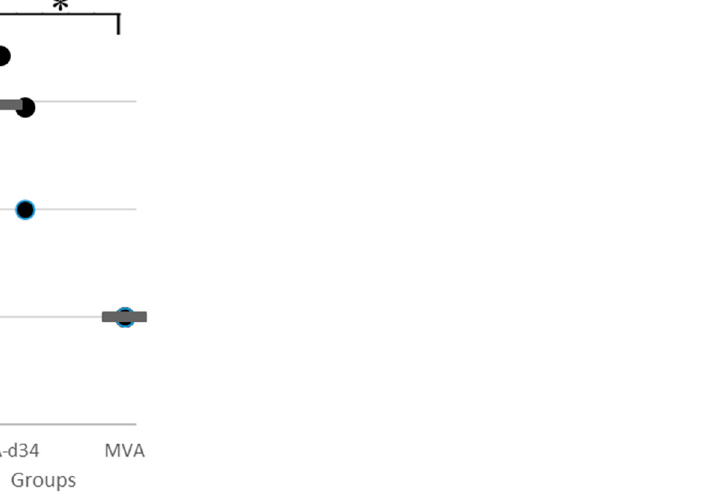
Figure 5. Antibody titer in blood sera of mice immunized with MVA-d34 (N = 5) or wt MVA (N = 5) measured via in-house indirect d34 ELISA. The mean value is shown by a thick line. The asterisk denotes a statistically significant difference between MVA-d34 group and wt MVA control group ( p -value < 0.05 according to the Mann-Whitney U test).